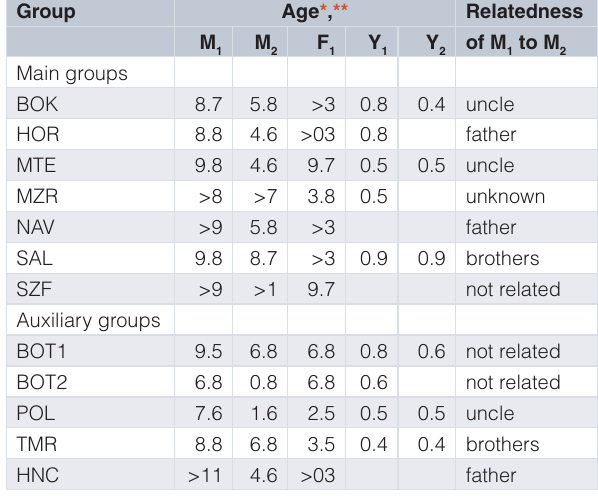
Table 1. Group composition, ages and relatedness among the males.